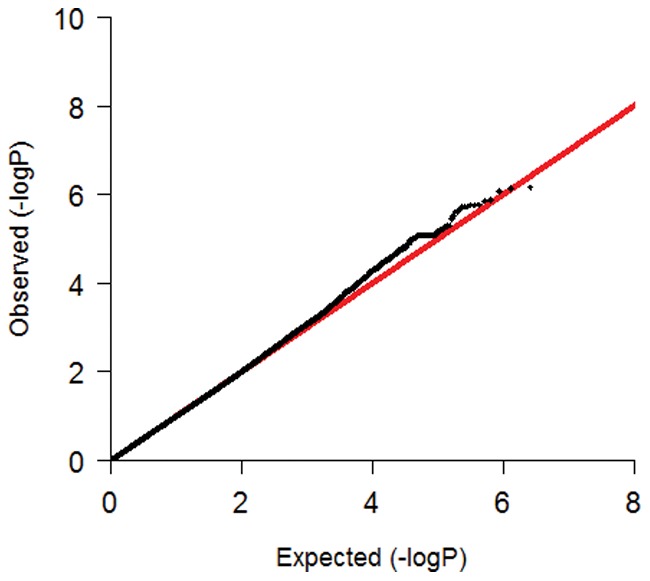
Q-Q plot for the GWAS after imputation on clinical restenosis in the GENDER study population. Lambda  = 1.027.